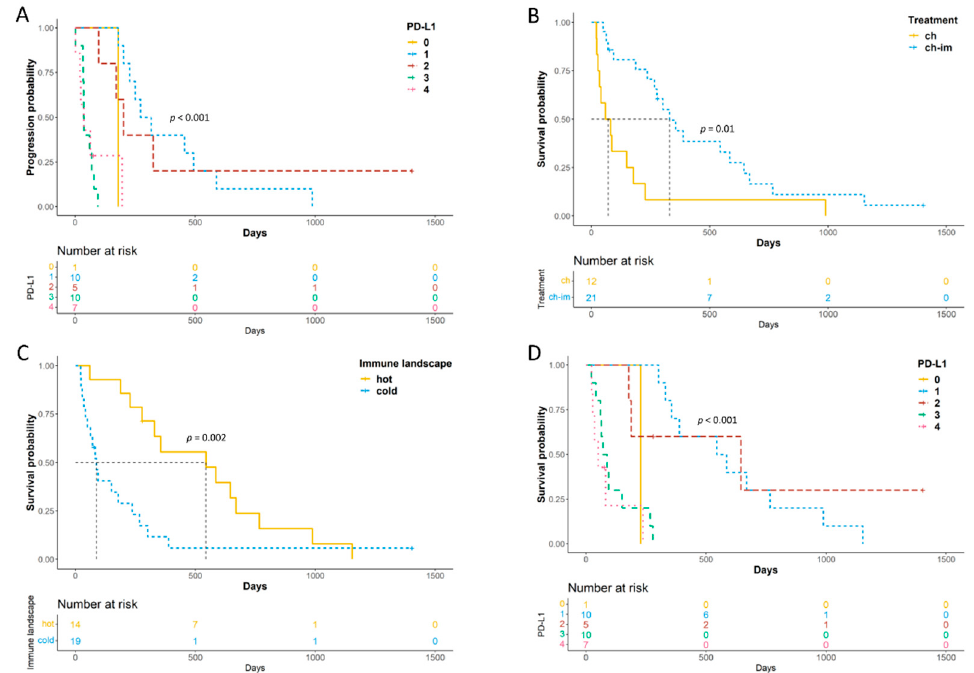
Figure 4. Kaplan–Meier (KM) for TTP and LSS of 33 dogs with cDLBCL. ( A ) KM curve of TTP according to PD-L1 RNAscope scores; ( B,C ) KM curves of LSS according to treatment ( B ) and immune signature enrichment status ( C ); ( D ) KM curve of LSS according to PD-L1 RNAscope scores.